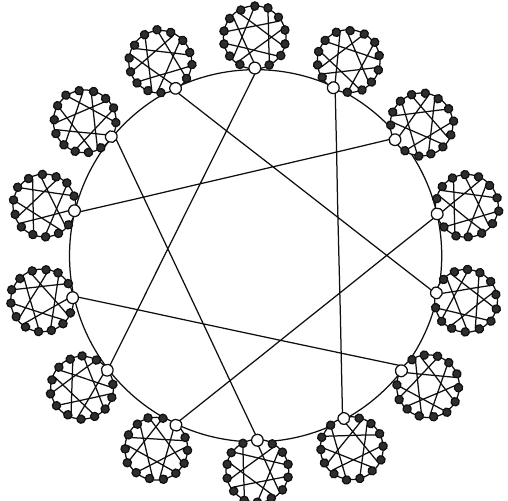
Figure 15: A 3-dimentinal FloH HIN [12].